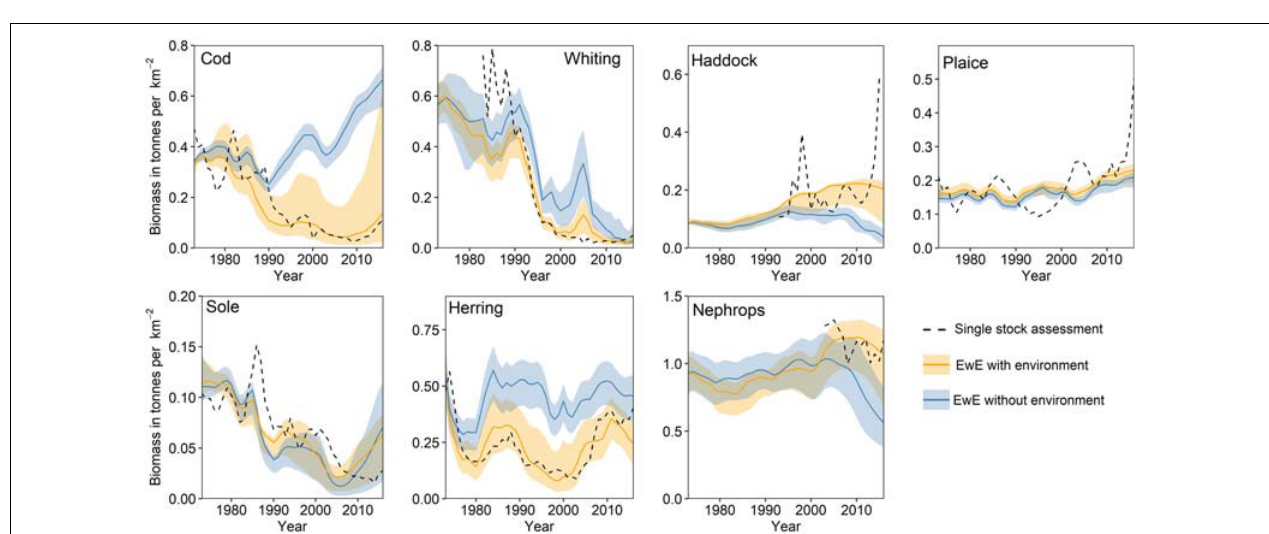
FIGURE 2 | ICES fisheries divisions and the Irish Sea. Map of the United Kingdom and Ireland with the surrounding waters broken down into their ICES advisory areas (left) , along with a map of the Irish Sea; ICES division VIIa (right) .